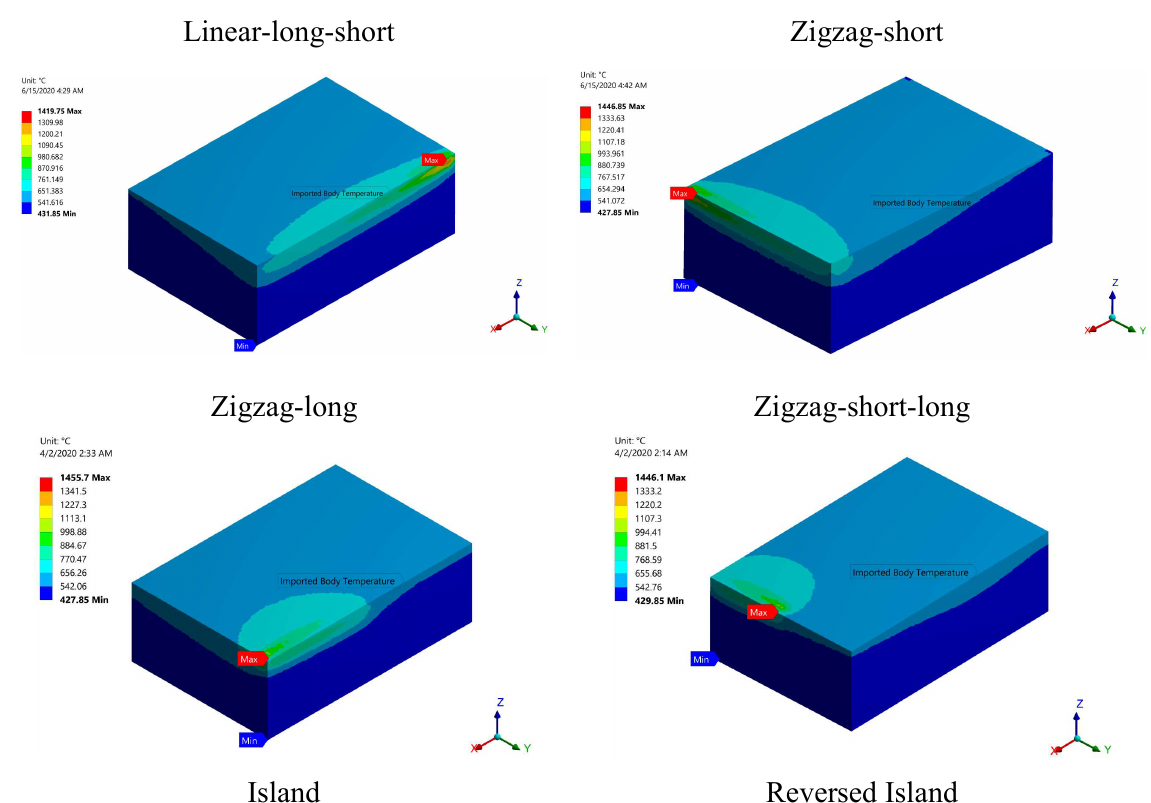
Figure 12. Temperature contours for the studied build ordinations just after solidification.